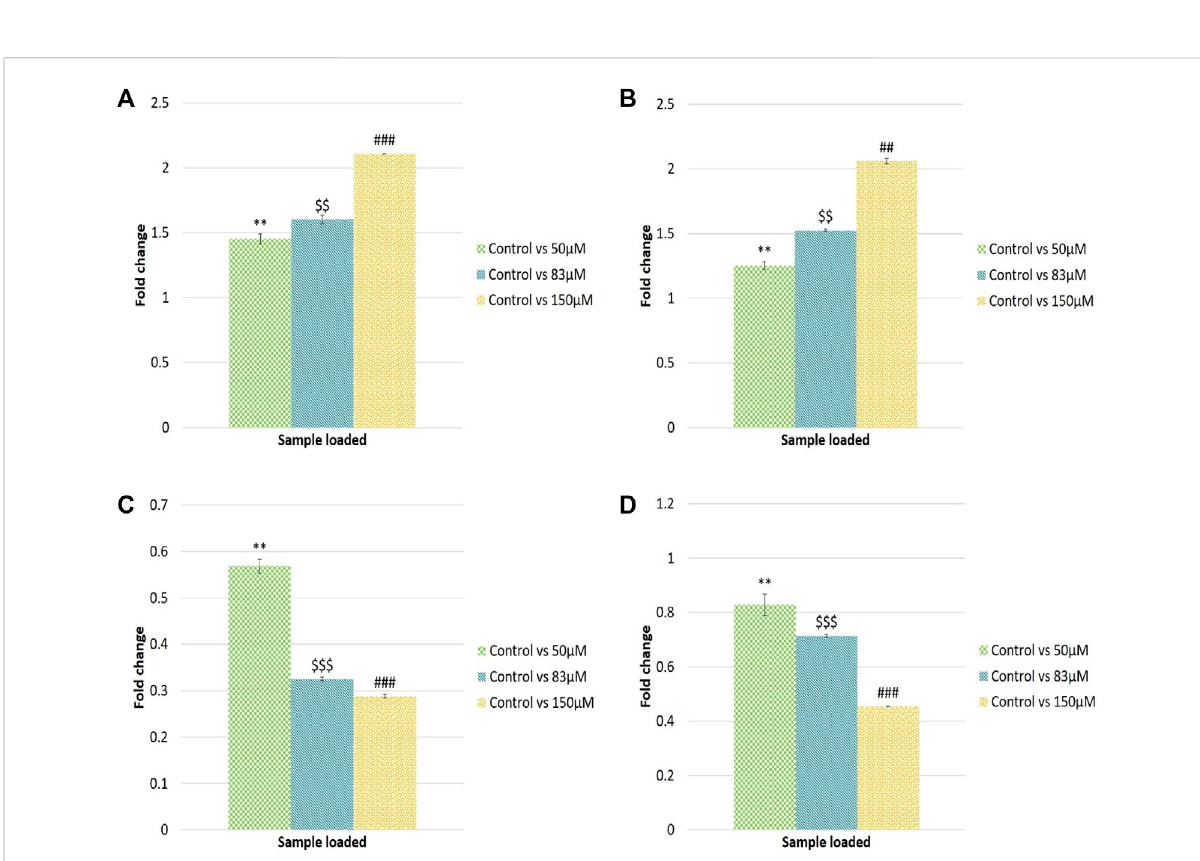
FIGURE 11 ValidationofrandomlyselectedknownmicroRNAsbyqRT-PCR. (A) Log2foldchangeofhsa-let-7e-5p; (B) Log2foldchangeofhsa-miR-320a; (C) Log2 fold change of hsa-miR-21-3p; (D) Log2fold change of hsa-miR-27a-3p microRNAs. The signi fi cance of differences between control vs. 50 µM EGCG indicated by “ * ” ; control vs. 83 µM EGCG indicated by “ $ ” ; control vs. 150 µM EGCG indicated by “ # ” . Signi fi cance levels of p < 0.005 ( “ *** ” ; “ $$$ ” ; “ ### ” ), p < 0.05 ( “ ** ” ; “ $$ ” ; “ ## ” ) are denoted. EGCG treatments were given for 24 h. Data are presented as mean ±